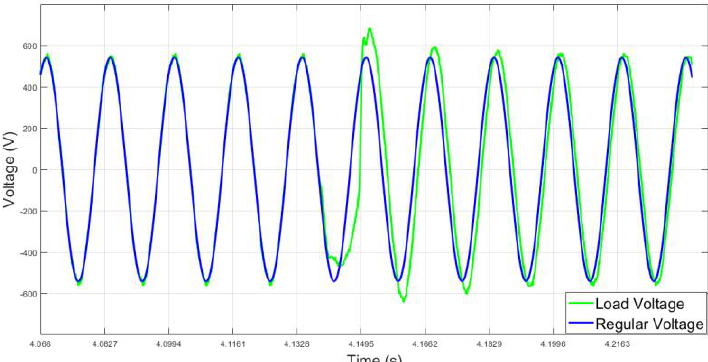
Figure 10. Stage 1: No-load backup — load voltage of analysis.